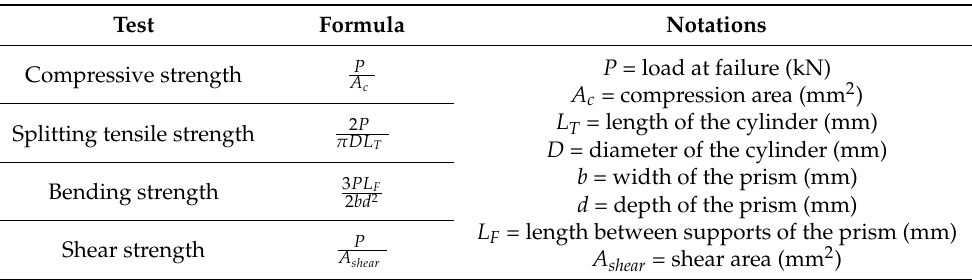
Table 5. Formulas for calculating the mechanical strengths.